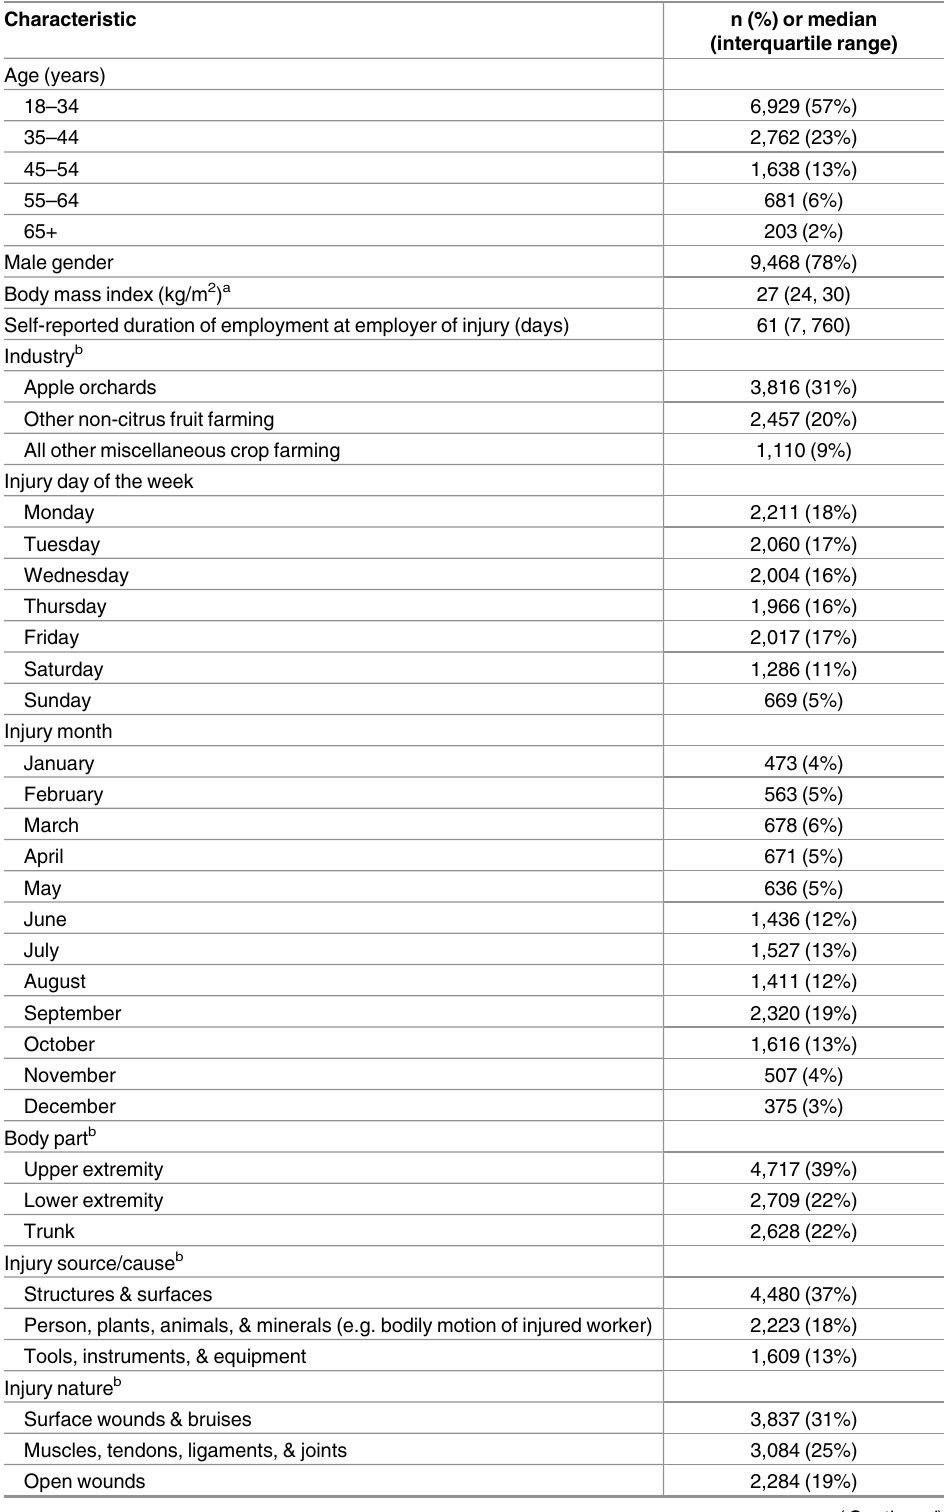
Table 1. Injury claim characteristics (N =